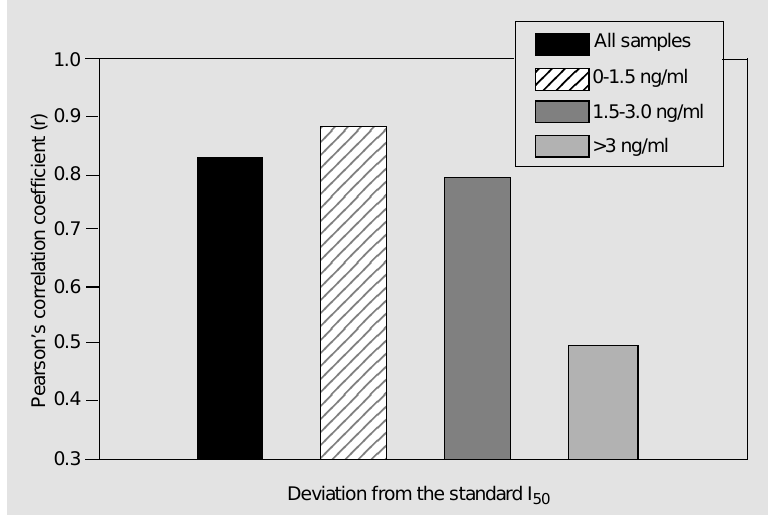
Figure 2. Pearson’s correlation coefficient between the results obtained by gas chromatog- raphy and by ELISA to determine caffeine concentration in 58 human plasma samples. The blocks express the deviation from the standard I 50 (in